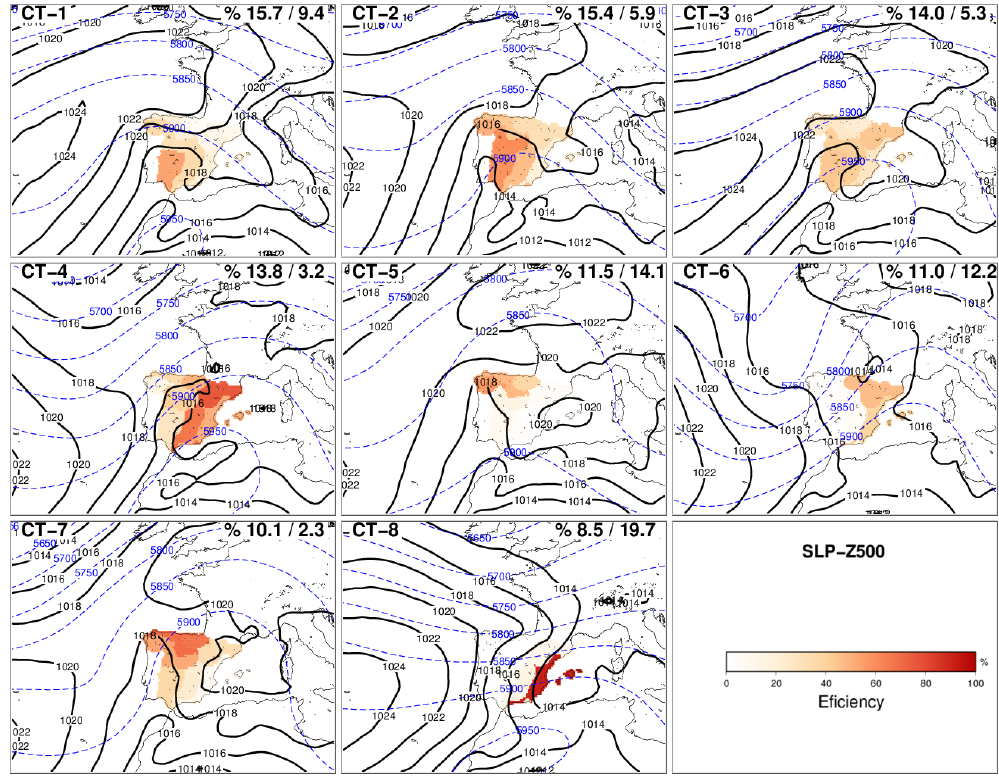
Figure 5. Same as Fig. 3 but for the SLP–Z500 classification. SLP and Z500 are represented by isobars (black lines) and contour levels (blue shaded lines). Table 5. Contributions (in percentage) of the CTs belonging to the best classification (last column) for each region. Region CT1 CT2 CT3 CT4 CT5 CT6